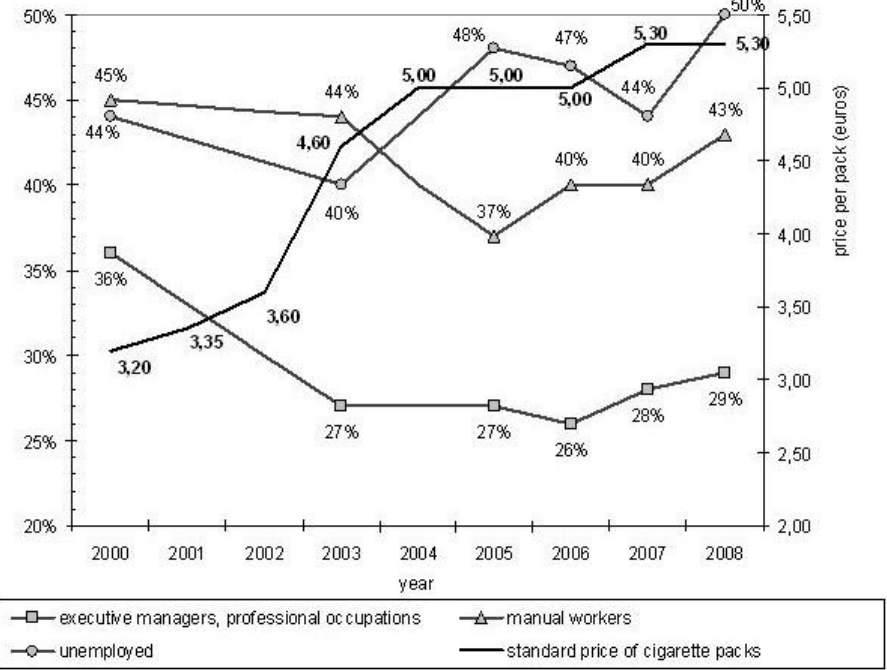
Figure 1. Trends in smoking prevalence for executive managers and professional occupations, manual workers and the unemployed, 2000-2008,